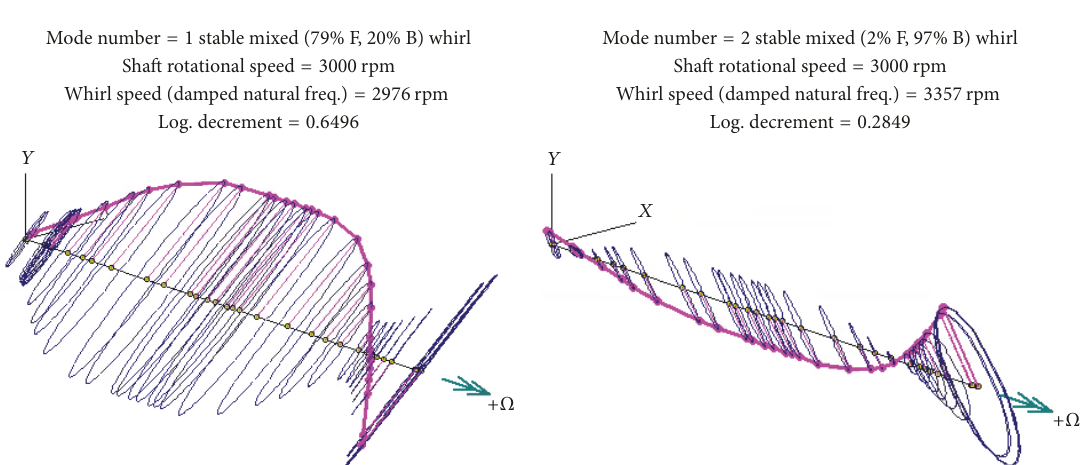
Figure 2: Modal analysis of four-lobe bearing-rotor system.